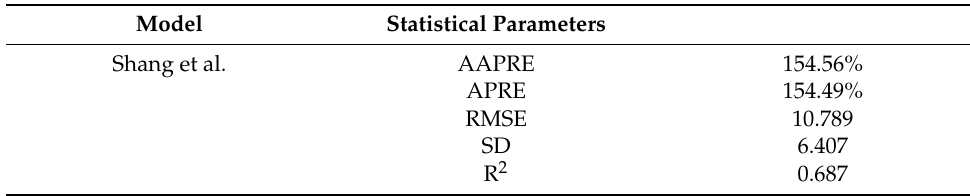
Table 3. Statistical parameters of the model available in the literature to determine the IFT values of CO 2 –n-alkane